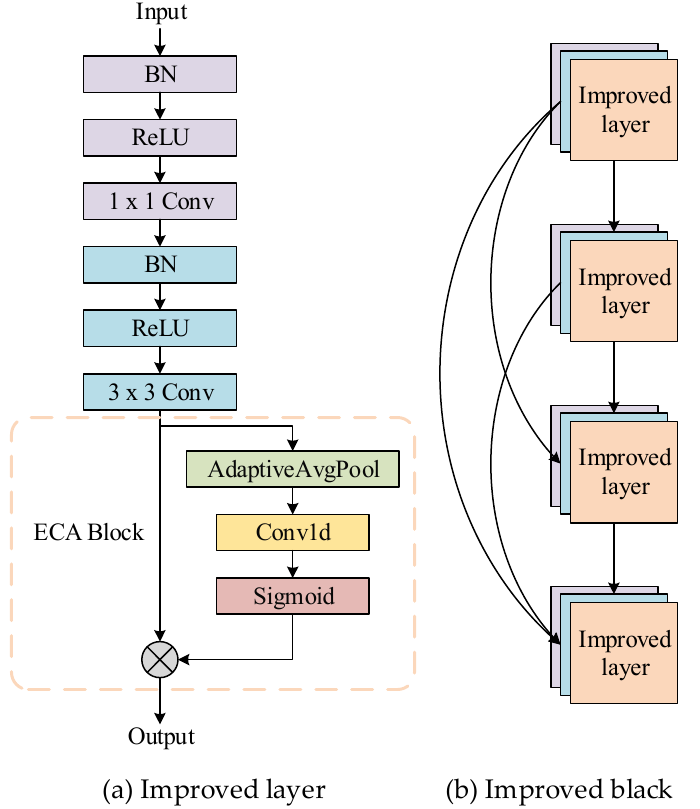
Figure 1. The structure of the improved DenseNet block.